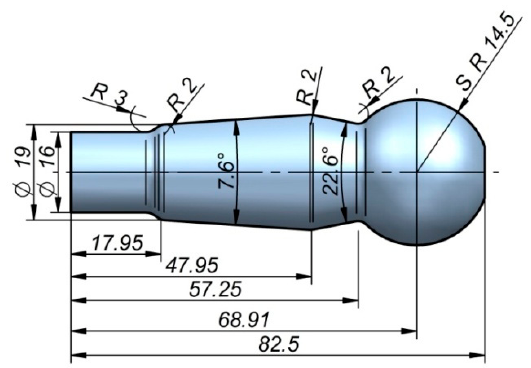
Figure 1. Ball stud used in the analysis of cross-wedge rolling (CWR) and helical-wedge rolling (HWR), with the dimension in mm given.